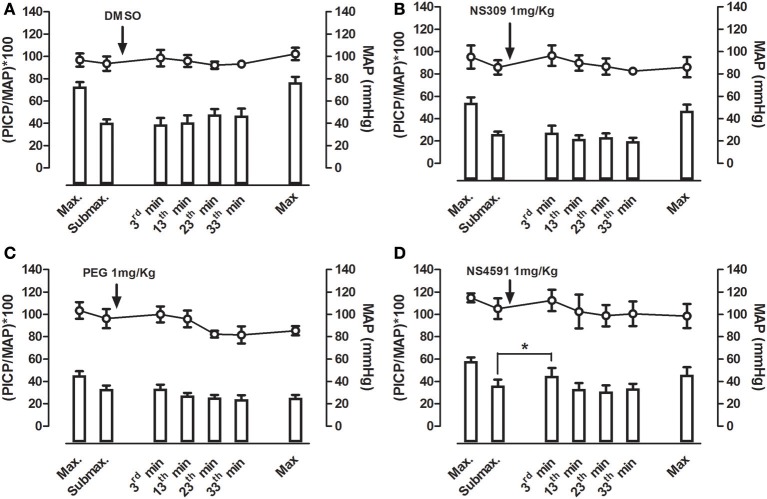
Average effect of NS309 and NS4591 on mean arterial pressure (MAP) and erectile function measured as peak intracavernosal pressure (PICP) over MAP in rats. A maximal and submaximal response to electrical stimulation was obtained before infusion of either vehicles, (A) dimethylsulpoxide (DMSO, 1 mgKg−1, n = 7), (B) polyethylene glycol (PEG, 1 mgKg−1, n = 7), (C) NS309 (1 mgKg−1, n = 5), or (D) of NS4591 (1 mgkg−1, n = 6), and the submaximal stimulations were performed 3, 13, 23, and 33 min after drug infusion. Finally, a maximal stimulation of the cavernous nerve was performed. The results show a facilitating effect on submaximal stimulation 3 min after NS4591 infusion. The direct effects of the drugs on MAP and intracavernosal pressure are depicted in Supplementary Figure S7. Data are expressed as means ± S.E.M. *P ≤ 0.05 compared with submaximal control response in the same animals using one-way ANOVA followed by Dunnett's test.